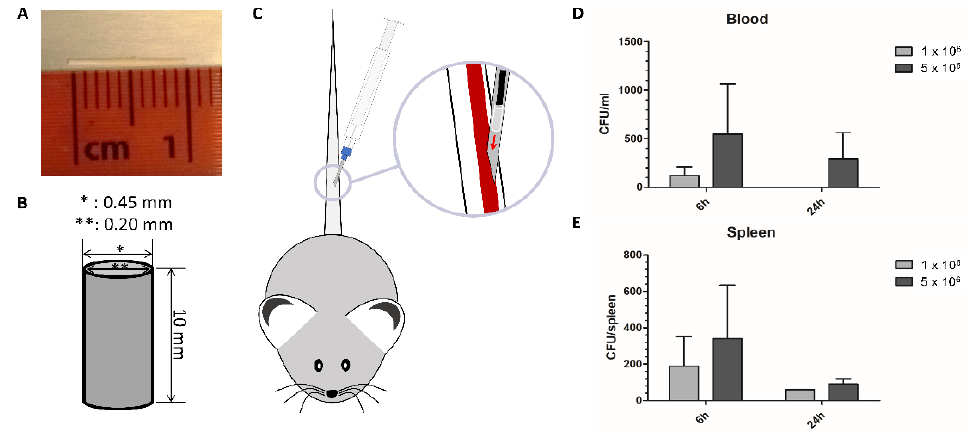
Figure 1. The implant used for the testing of antimicrobial material properties in the bloodstream is ( A ) photographically and ( B ) schematically illustrated (*: uter diameter, **: inner diameter) as well as the implantation procedure ( C ). Bacterial load of ( D ) the blood and ( E ) the spleen are shown by colony forming units (CFU)/mL or per organ for the implants with low (1 × 10 6 ) and high (5 × 10 6 ) implant contamination concentration.